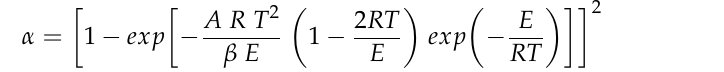
Figure 9. Comparison between experimental and random scission theoretical values of conversion for the thermal degradation of PLA in the bioblend containing 90% PLA. 5. Conclusions The thermal stability and potential degradation mechanisms of PLA in PLA/bio- based PA 10.10 were analyzed. In this case, a matrix of a rheologically modified PLA from reactive extrusion was employed, with the addition of 10–50% of biobased PA as a second